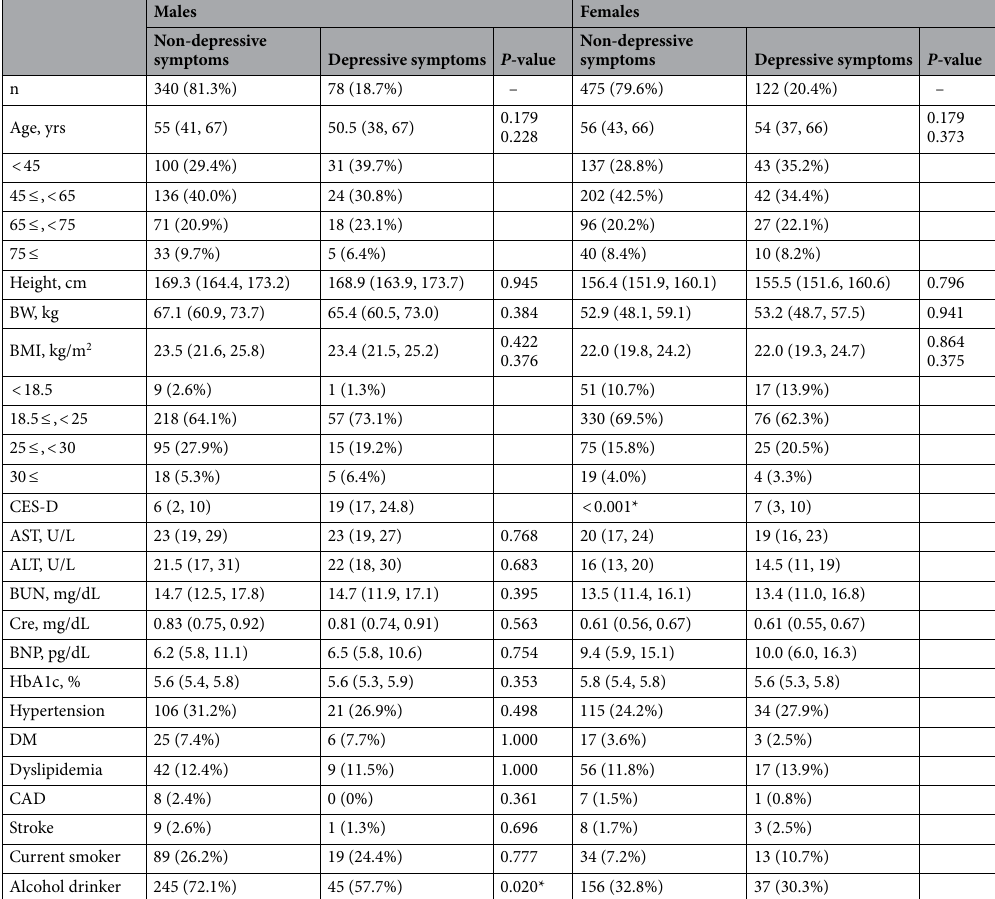
Table 1. The subjects’ characteristics. * P < 0.05. Differences between the non-depressive symptoms and depressive symptoms groups were examined by Fisher’s exact test for categorical variables and Mann–Whitney test for continuous variables. Data are shown as number (a percentage of each group) or median (25 to 75th percentile). ALT alanine transferase, AST aspartate transferase, BMI body mass index, BNP B-type natriuretic peptide, BUN blood urea nitrogen, BW body weight, CAD coronary artery disease, CES-D Center for Epidemiologic Studies Depression Scale, Cre creatinine, DM diabetes mellitus, HbA1c hemoglobin